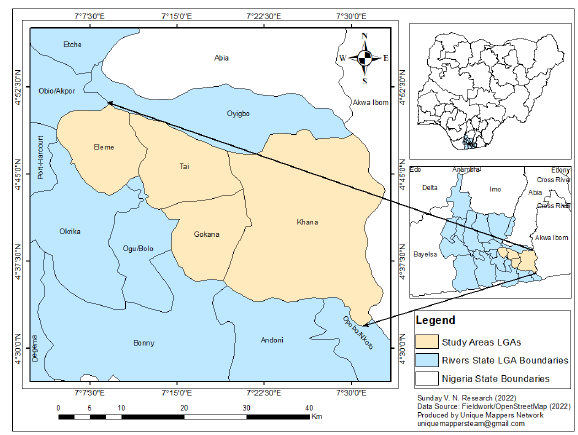
Figure 1: Ogoni Land LGAs, Rivers State, Niger Delta Region, Nigeria